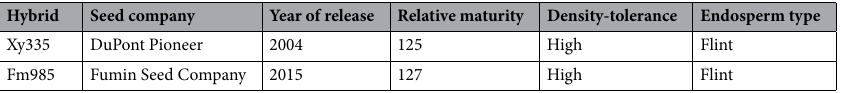
Table 4. Characteristics of maize hybrids used in the experiments.